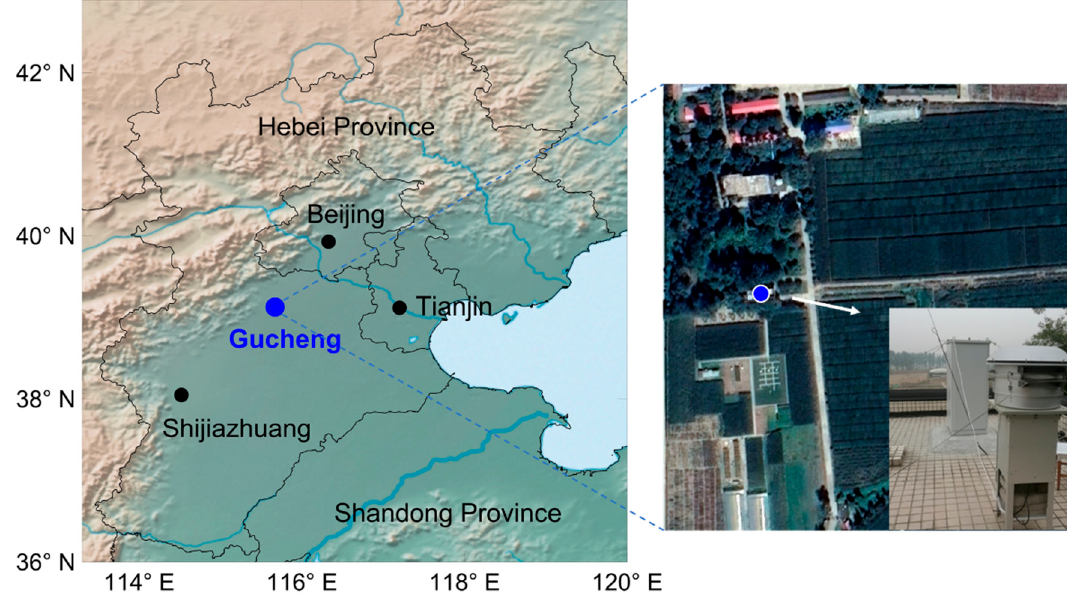
Figure 1. Location of the Gucheng site.